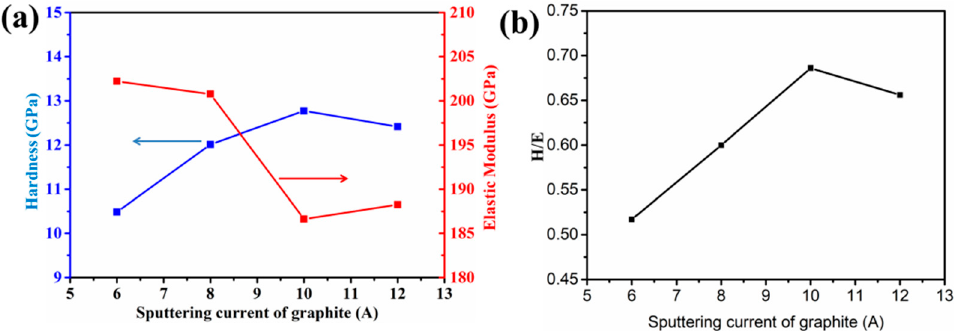
Figure 8. ( a ) Hardness and elastic modulus; ( b ) H/E ratio of the multilayered films with various bilayer periods.